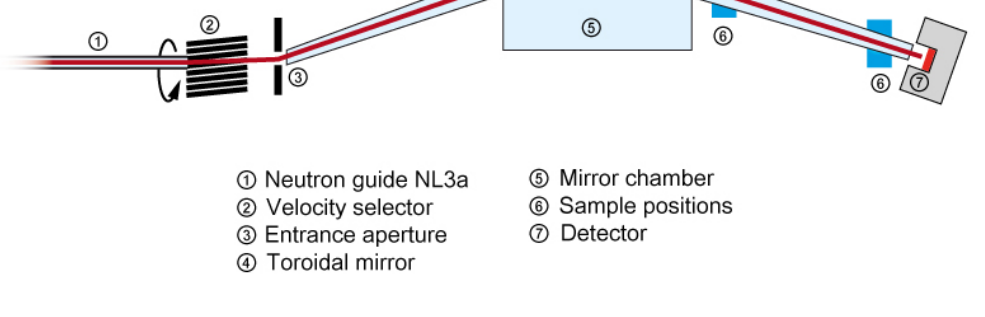
Figure 2: Schematic drawing of